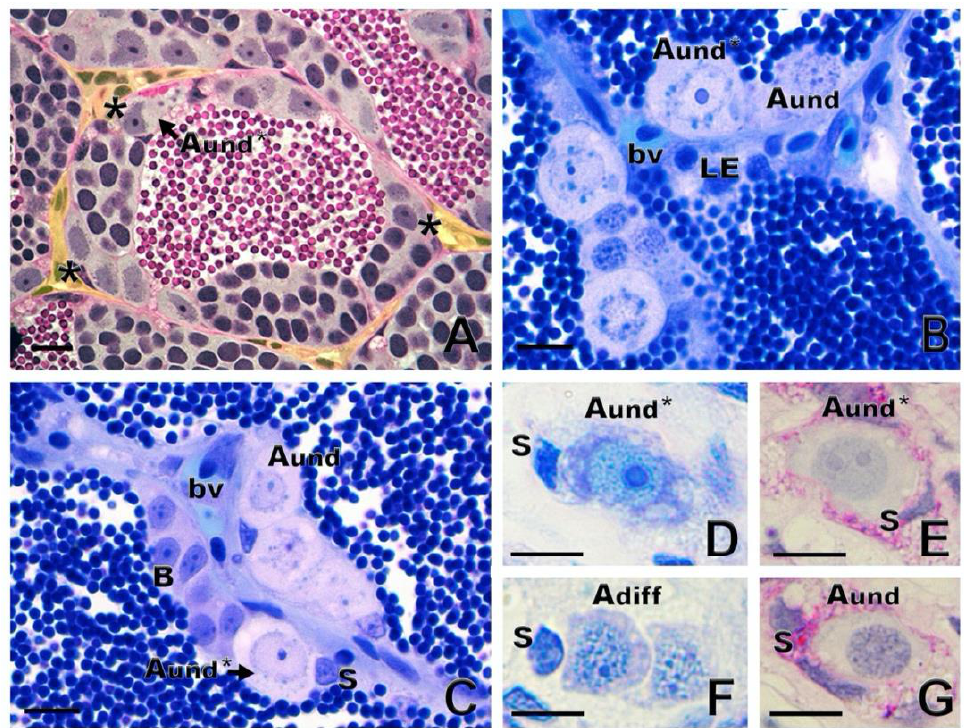
Figure 4. Spermatogonial niche and type A undifferentiated (A und ) spermatogonia. ( A ) Asterisks show the most undifferentiated type A spermatogonia (A und* ), preferentially located near the interstitial compartment (delimited in yellow) in zebrafish Danio rerio . ( B,C ) In common carp Cyprinus carpio , both A und* and A und are located near the interstitium, close to Leydig cells (LE) and blood vessels (bv). Sertoli cell (S) and type B spermatogonia are shown. ( D – G ): Generations of sterlet Acipenser ruthenus spermatogonia: A und* and A und and type A differentiated (A diff ) spermatogonia. Staining: periodic acid–Schiff ( A , E , G ) and toluidine blue ( B , C , D , F ). Scale bar: 10 µm.